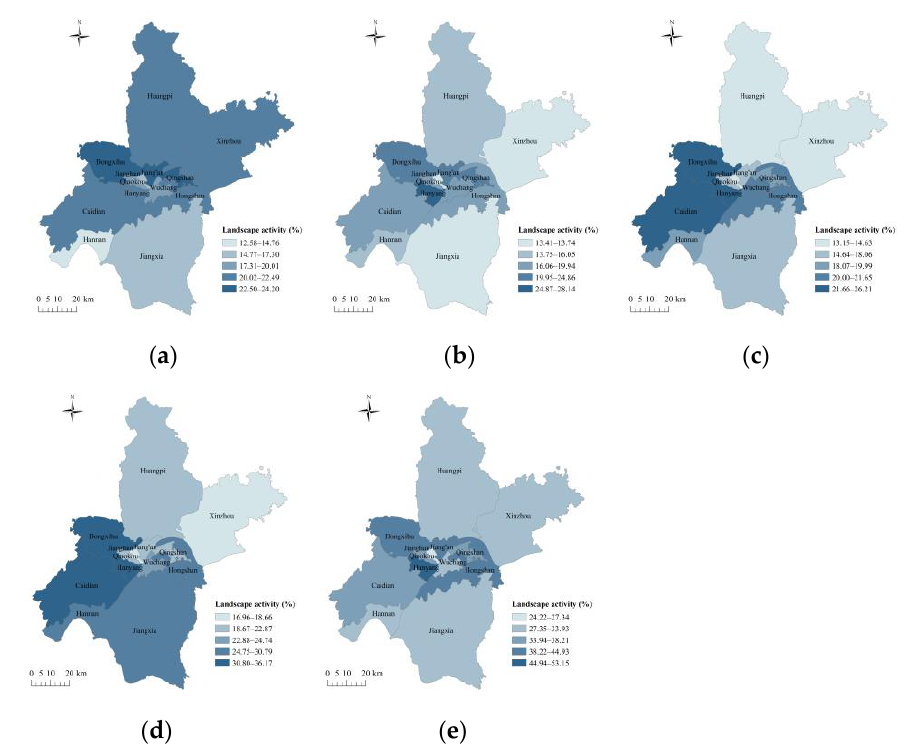
Figure 9. The spatial pattern of landscape activity of different districts in Wuhan in various periods: the landscape activity pattern during the period ( a ) 2000 – 2004; ( b ) 2004 – 2009; ( c ) 2009 – 2014; ( d ) 2014 – 2019; and ( e ) 2000 – 2019.